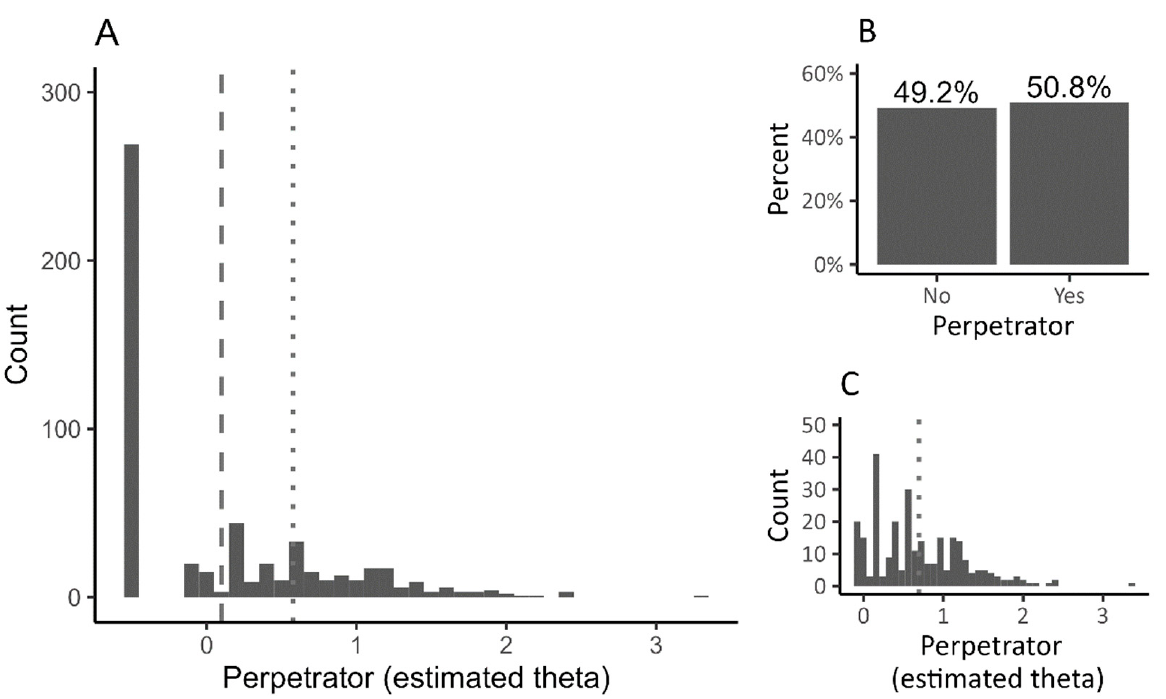
Figure 2. Distribution of the respondents according to being a perpetrator. Note: Panel ( A ) shows the distribution of the latent variable that illustrates the intensity of being a perpetrator (all respondents). Panel ( B ) shows the percentage of respondents who selected ‘Never’ for each of the six types of cyberbullying (category: ‘No’) and those who had engaged in some form of cyberbullying (category: ‘Yes’). Panel ( C ) illustrates the distribution of the latent variable of respondents who had participated in some form of cyberbullying (that is, after removing respondents who had never participated in any form of cyberbullying). The “dashed” line indicates the mean for all individuals ( M = 0.10). The “dotted” line indicates the mean after eliminating respondents not involved in being the perpetrator ( M = 0.69).